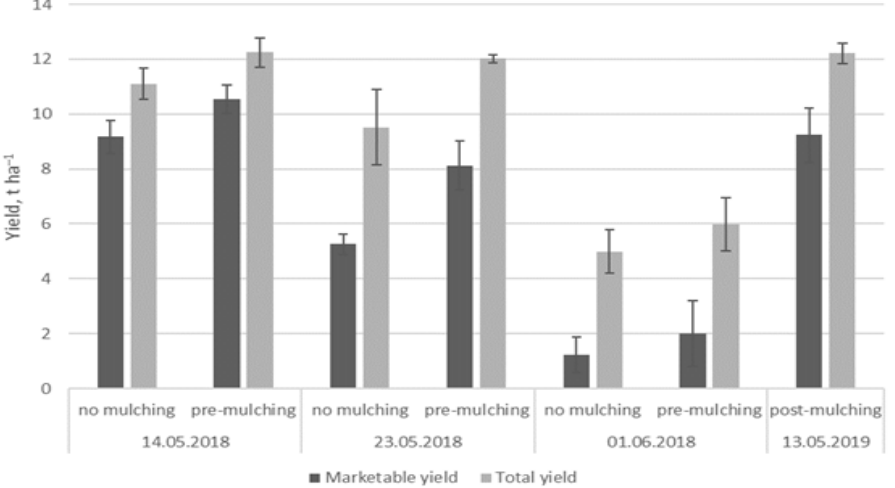
Figure 6. Marketable and total yield of vegetable soybean at three different sowing times, and with different soil mulching strategies in field trials in Norway in year 2018 and 2019. n =